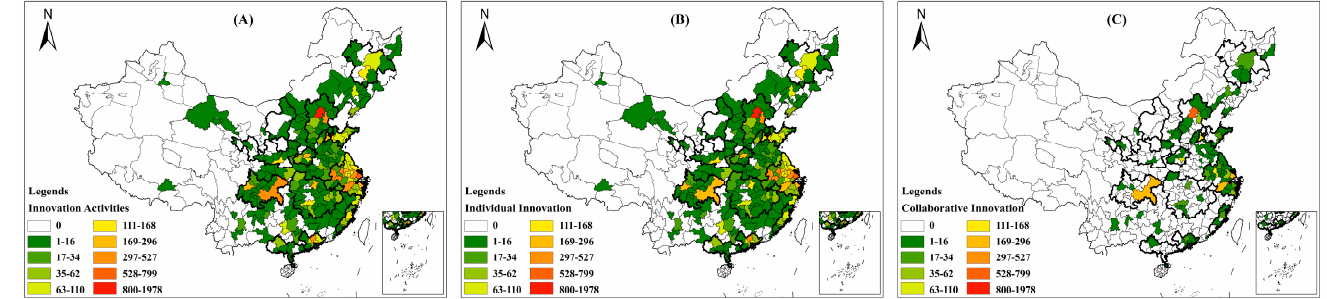
Figure 1. The distribution of China’s NEV innovation: ( A ) is the distribution of innovation activities, ( B ) is the distribution of individual innovation, and ( C ) is the distribution of collaborative innovation.